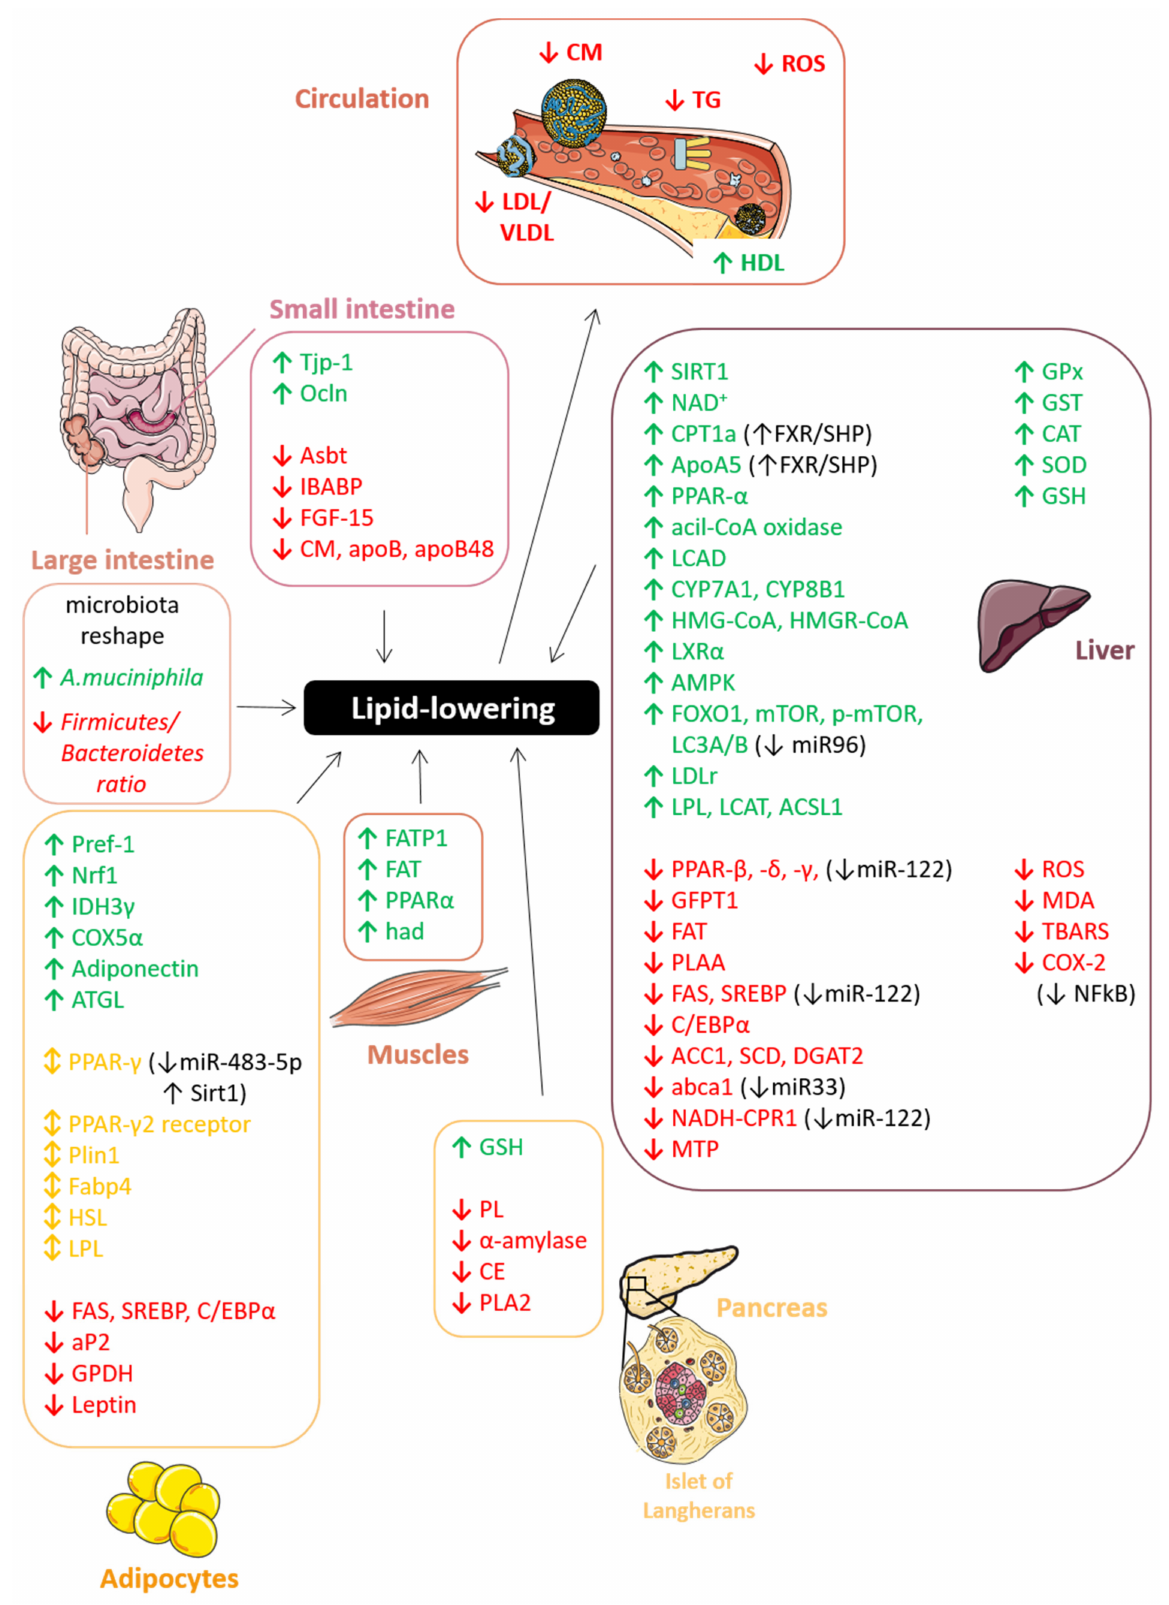
Figure 17. Schematic representation of the molecular mechanisms through which PACs affect lipid metabolism protect- ing against hyperlipidemia. ↑ increase; ↓ decrease; (cid:108) increase/decrease. The figure was created using Servier Medi- cal Art by Servier (smart.servier.com accessed on 12 March 2021), licensed under a Creative Commons Attribution 3.0 Unported